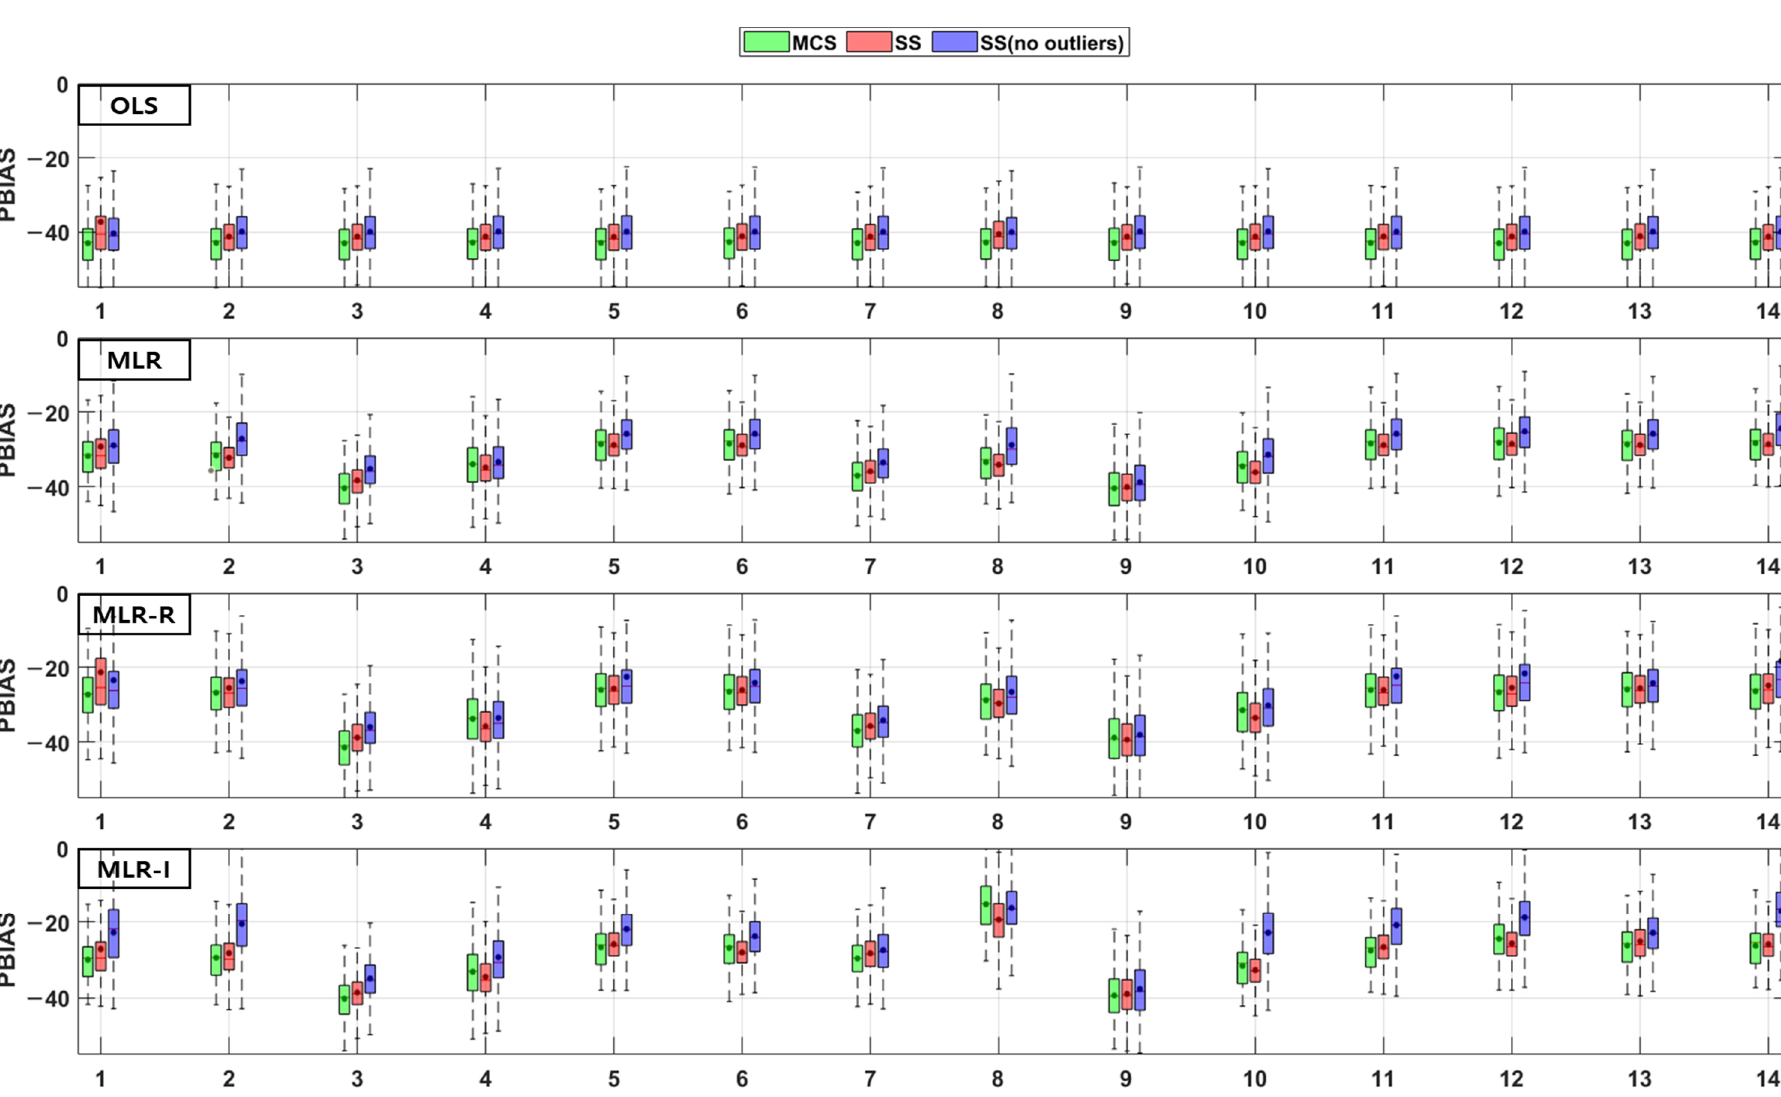
Figure 10. Error analysis (PBIAS) results of TSS removal in retention ponds.